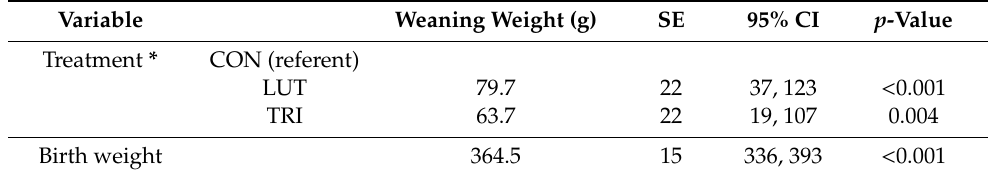
Table 1. The final model ◦ illustrating the e ff ect of fixed-time artificial insemination (FTAI) (LUT and TRI *) versus conventional breeding on the piglet weaning weight (g) for gilts. Variable Weaning Weight (g) SE 95% CI p -Value Treatment * CON (referent) LUT 79.7 22 37, 123 < 0.001 TRI 63.7 19, 107 0.004 Birth weight 364.5 336,